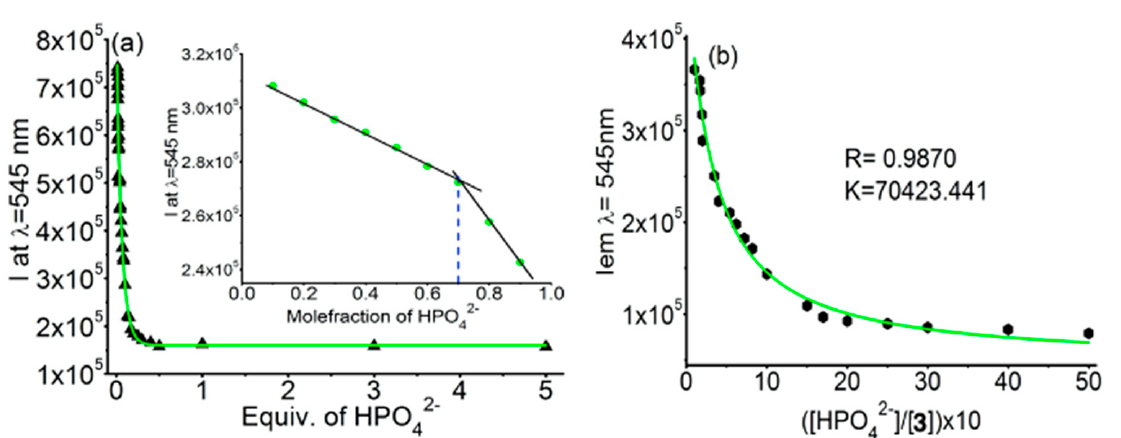
Figure 3. ( a ) Changes in emission maxima of 2 (4 × 10 − 5 M) upon gradual addition of HPO 42 − in aqueous HEPES buffer at pH = 7.4; ( b ) nonlinear curve fitting of the titration data as a function of HPO 42 − concentrations in the range 0.01–18 equiv. (luminescence enhancement part); ( c ) nonlinear curve fitting of the titration data as a function of HPO 42 − concentrations in the range 20–800 equiv. (luminescence quenching part); and ( d ) Job’s plot of complex 2 with HPO 42 − ( C complex 2 + C HPO42 − = 1.0 µ M) in aqueous HEPES buffer pH 7.0 showing 1:2 complex formation ( λ emi = 644 nm).